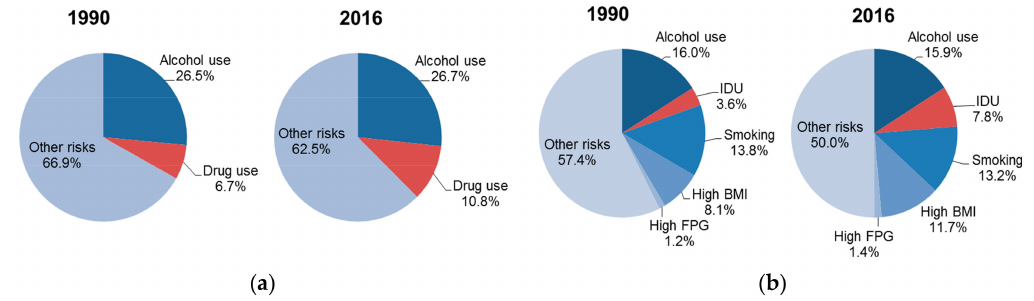
Figure 1. Risk-specific disease mortality on the global level in 1990 and 2016 for ( a ) cirrhosis; ( b ) liver